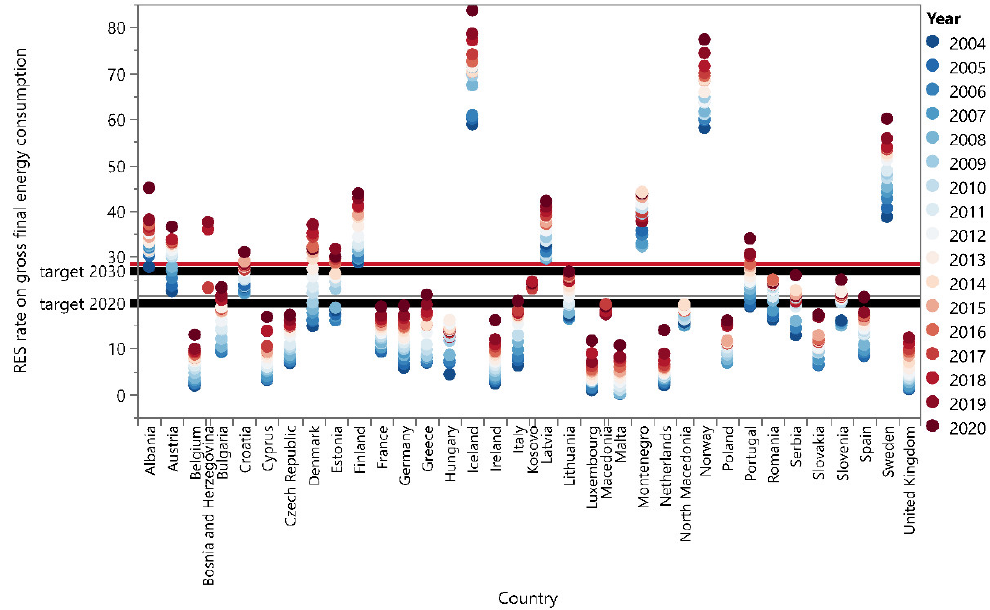
processing according to [21], processing in JMP.